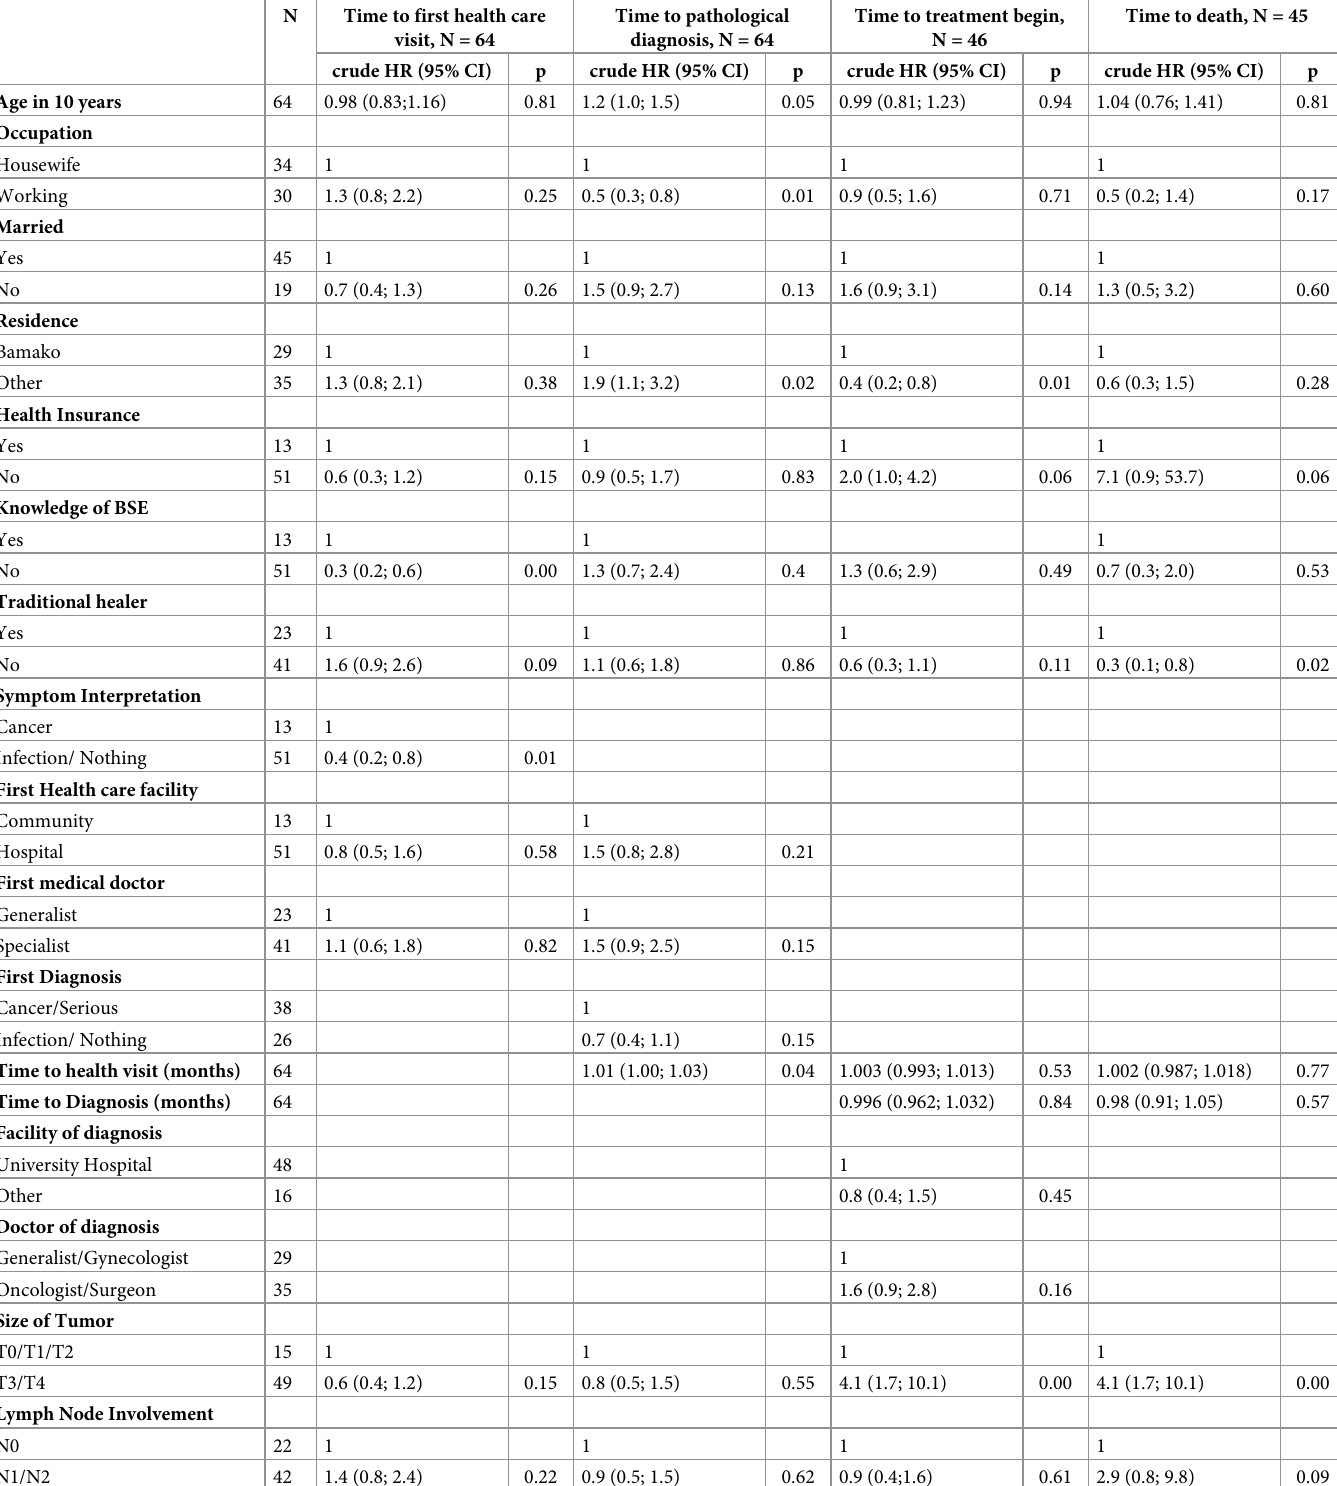
Table 1. Distribution, HR (95% CI) and p values for factors associated with time to first healthcare visit, diagnosis, treatment and